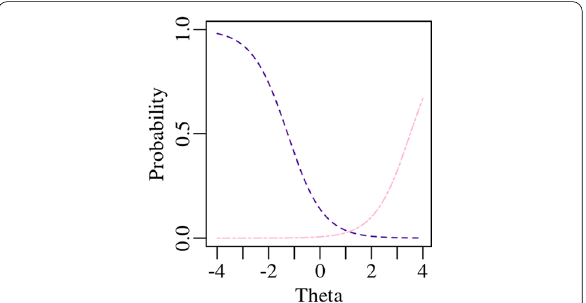
Fig. 4 Extreme response option probabilities across theta for PROMIS Fatigue item FATEXP42